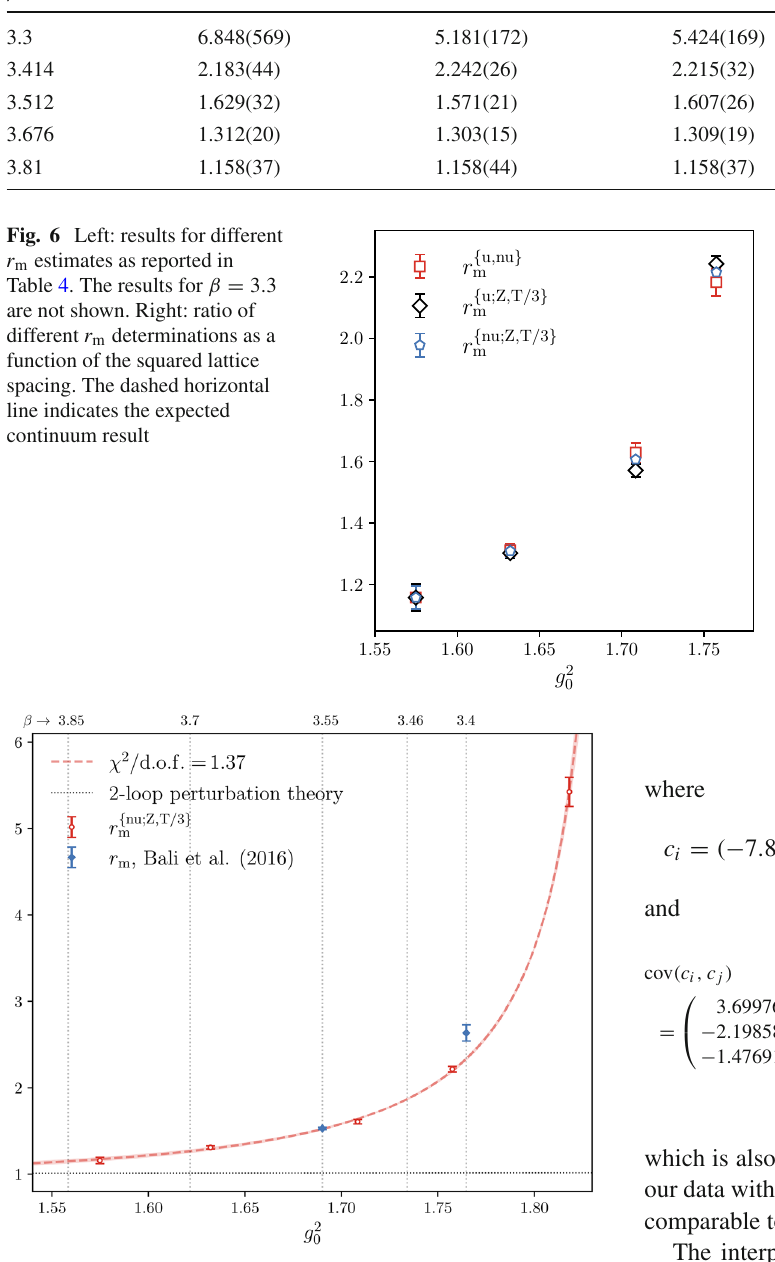
{ nu ; Z , T / 3 } Fig. 7 Non-perturbative determination of r m (open circles), compared to the results of Ref. [13] (filled diamonds) and those of two- loop perturbation theory [18] (horizontal dotted line). The dashed line is the interpolation (5.5) and the vertical dotted lines correspond to the bare couplings used in CLS simulations